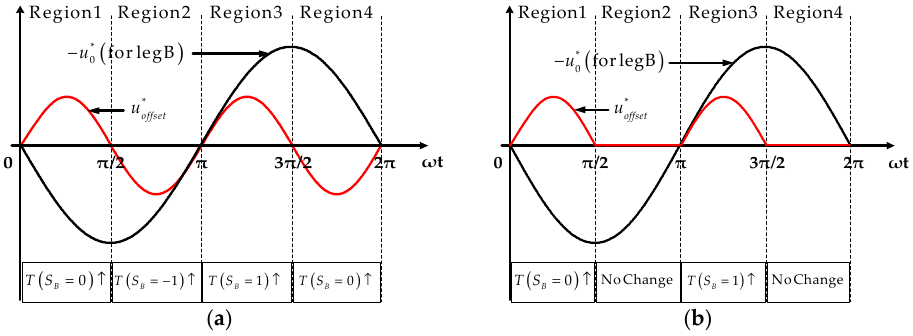
Figure 5. Waveforms pole voltage reference signal u x 0 * and offset signal u offset * . ( a ) Second-order harmonic signal; and ( b ) half-wave signal of second-order harmonic.